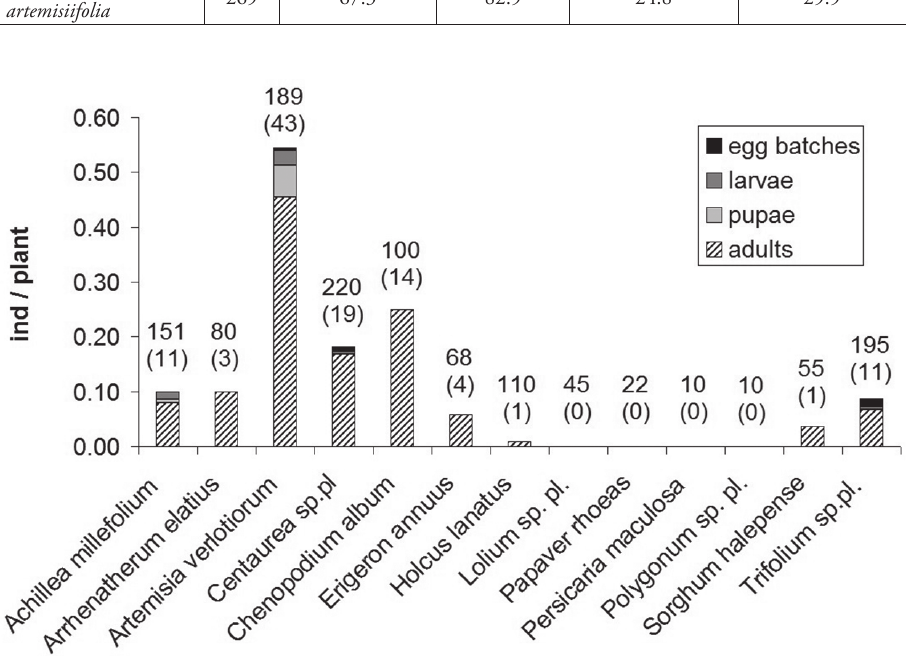
Figure 2. O. communa density on non-target species. Number of O. communa per plant on non-target species monitored during summer 2015. On the top of each bar is reported the number of observed plants and, in brackets, the plants with O. communa presence. Reference value of O. communa presence on A. artemisiifolia plants ( n = 269, 181 with O. communa ) are: 1.01 egg batches/plants: 0.69 larvae/plants, 0.21 pupae/plants, 1.99